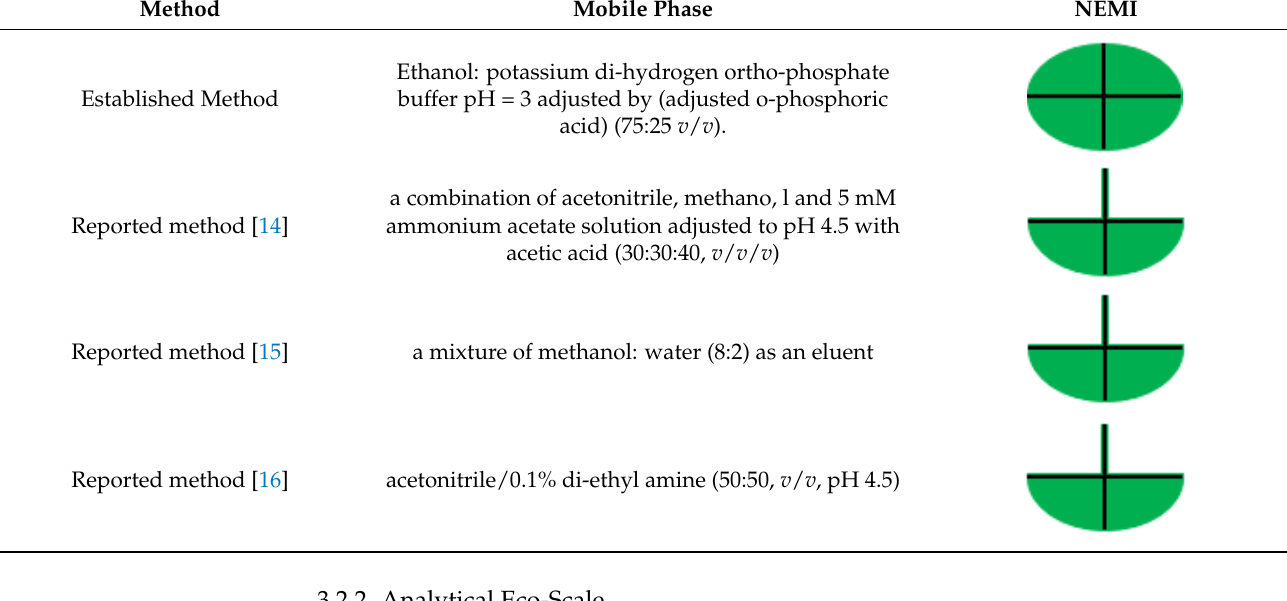
Table 4. Comparison of greenness profile between the proposed and reported HPLC methods. Method